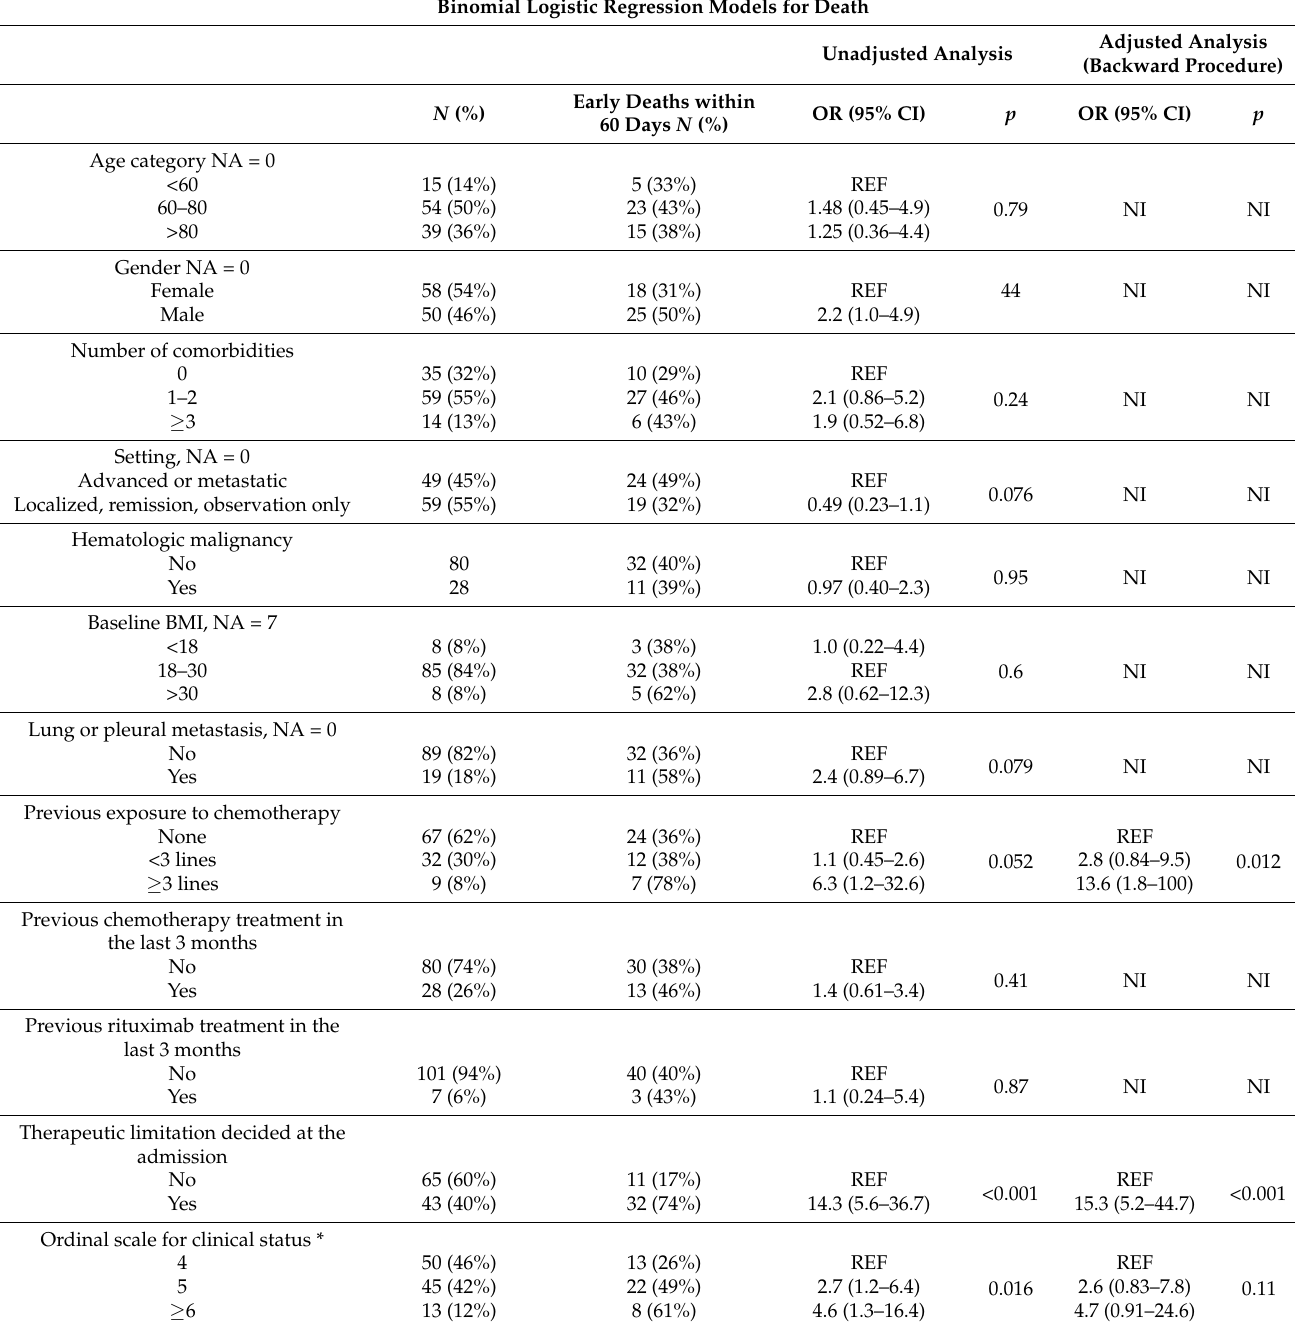
Table 4. Univariate and multivariate analysis of risk of death according to patient and tumor characteristics within the cancer